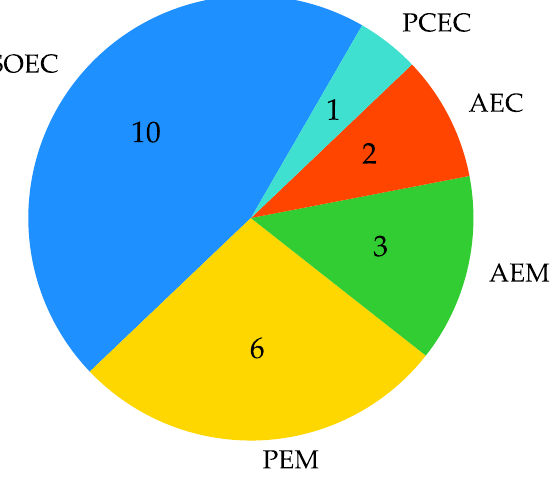
Figure 18. Number of projects per electrolyzer technology developed.